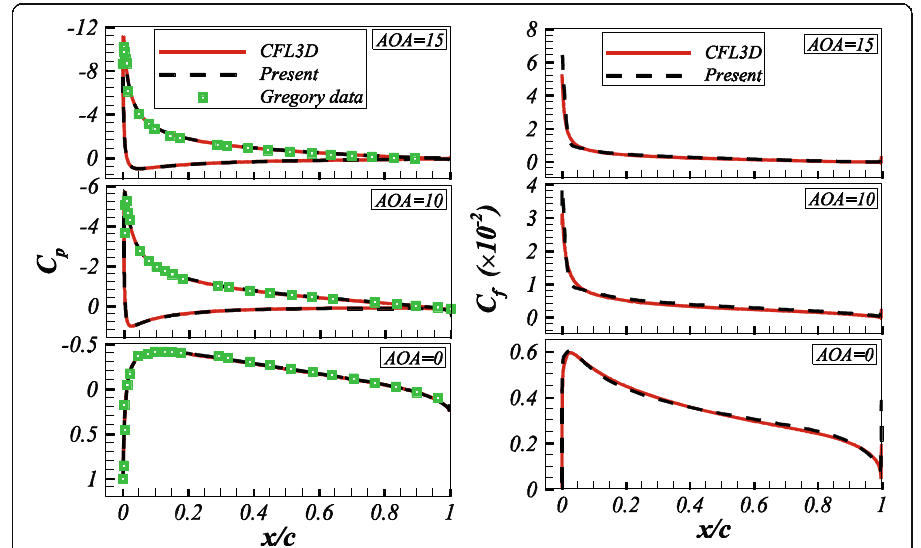
Fig. 9 The comparison of surface pressure C p and skin friction coefficient C f of NACA0012